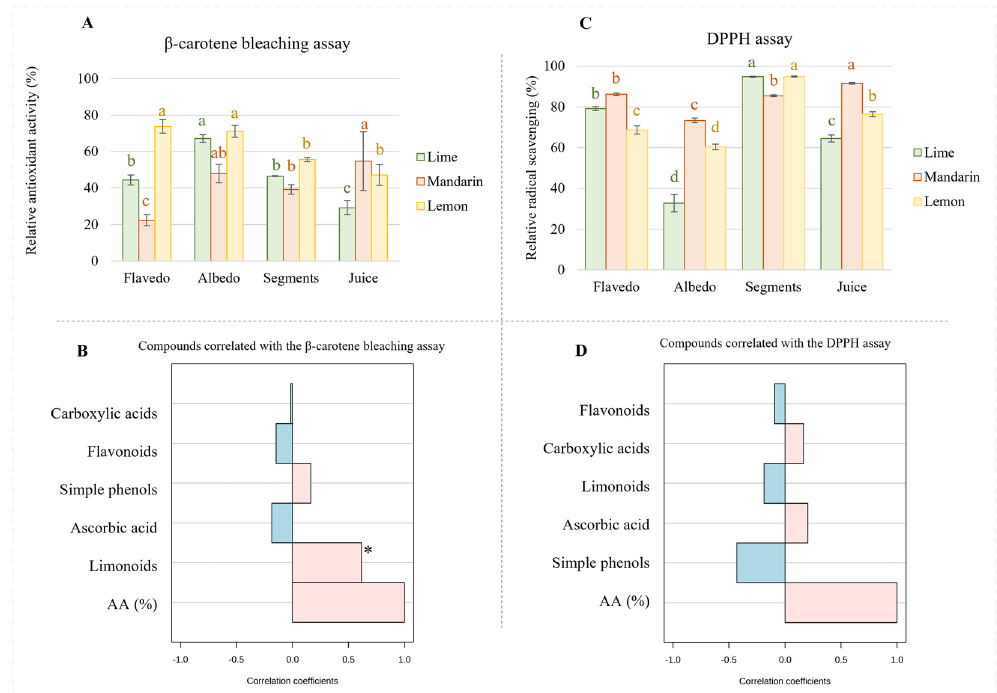
Figure 4. Antioxidant activity ( A ) and radical scavenging capacity ( B ) measured in extracts from citrus fruits. Spearman correlation between antioxidant assays and concentrations of families of metabolites ( β -carotene test, ( C ); DPPH assay, ( D )). Di ff erent le tt ers for the same fruit indicate signi fi cant di ff erences among tissues extracts in terms of antioxidant or radical scavenging activity. * p -value < 0.001.